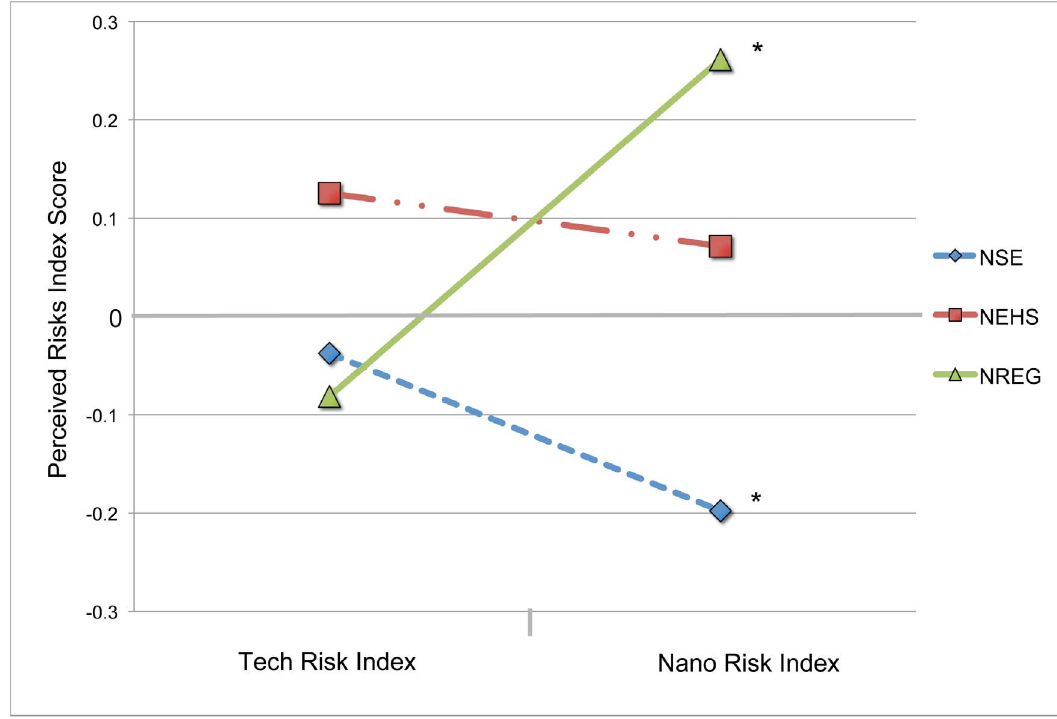
Figure 5. Comparison of Tech Risk Index and Nano Risk Index scores by expert group. Paired t-test scores confirmed a significant difference in means between Tech Risk Index and Nano Risk Index for the both the NREG group (Tech Risk Index M= 2 0.08, SD=0.99; Nano Risk Index M=0.26, SD=0.90), and for the NSE group (Tech Risk Index M= 2 0.04, SD=0.82; Nano Risk Index M= 2 0.20, SD=0.84). * indicates significant difference in means between Tech Risk Index and Nano Risk Index scores.